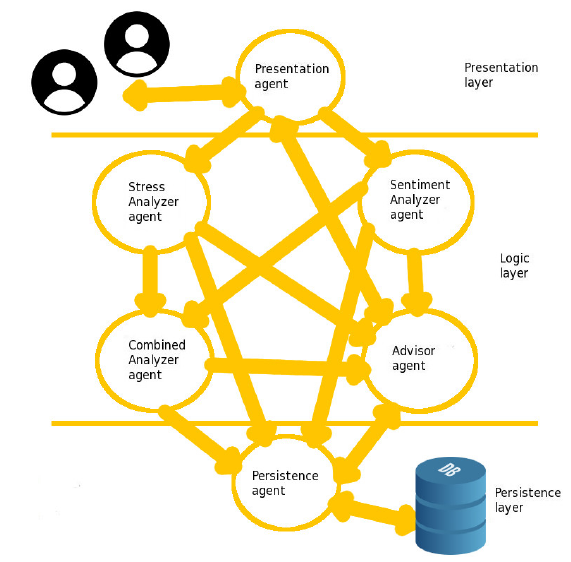
Figure 1. Architecture of the system built as a Multi-Agent System (MAS) with three